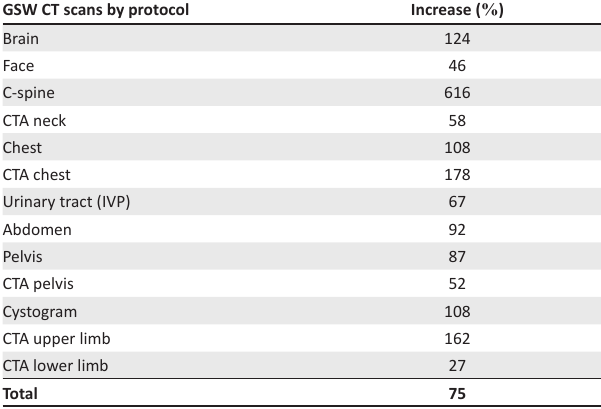
TABLE 2: Gun shot computed tomography scan